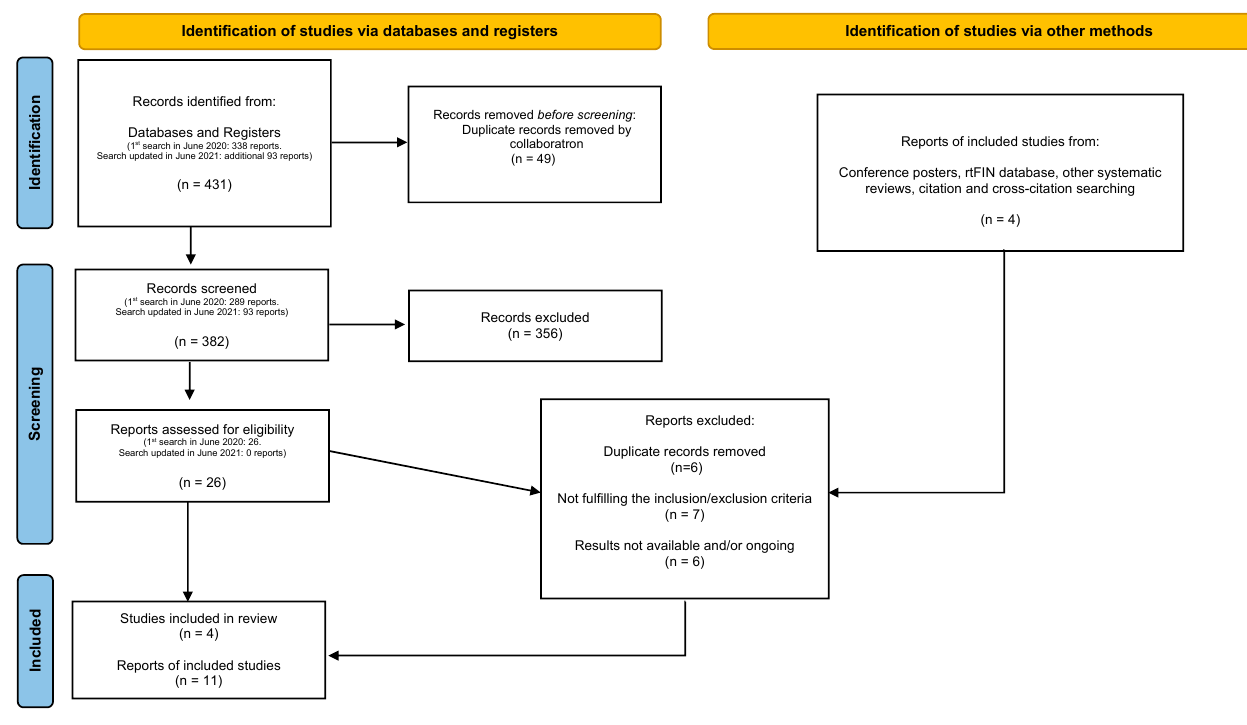
Figure 1. PRISMA flow